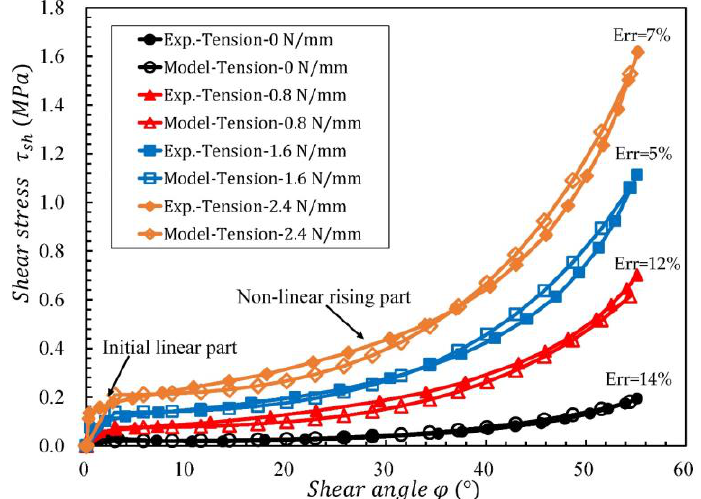
Figure 10. Comparison between the analytical model and experimental data of a carbon plain-woven fabric under bi-axial tension and shear load.